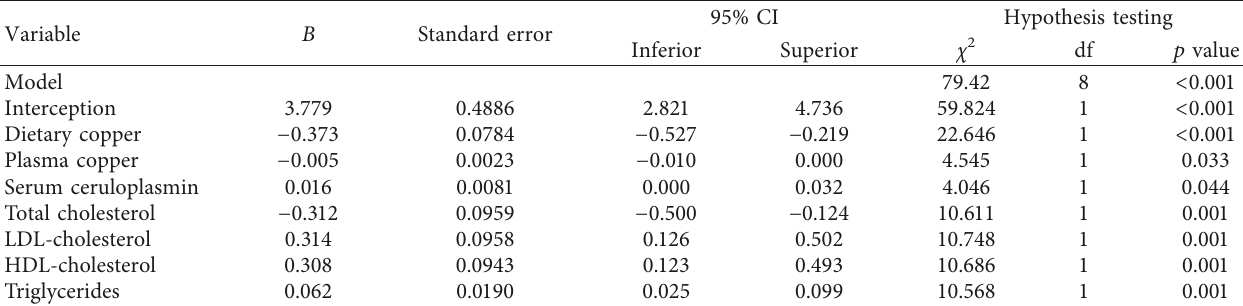
Table 3: Association of Amyotrophic Lateral Sclerosis Functional Rating Scale-Revised (ALSFRS-R) with copper and lipid biomarkers in patients with amyotrophic lateral sclerosis.